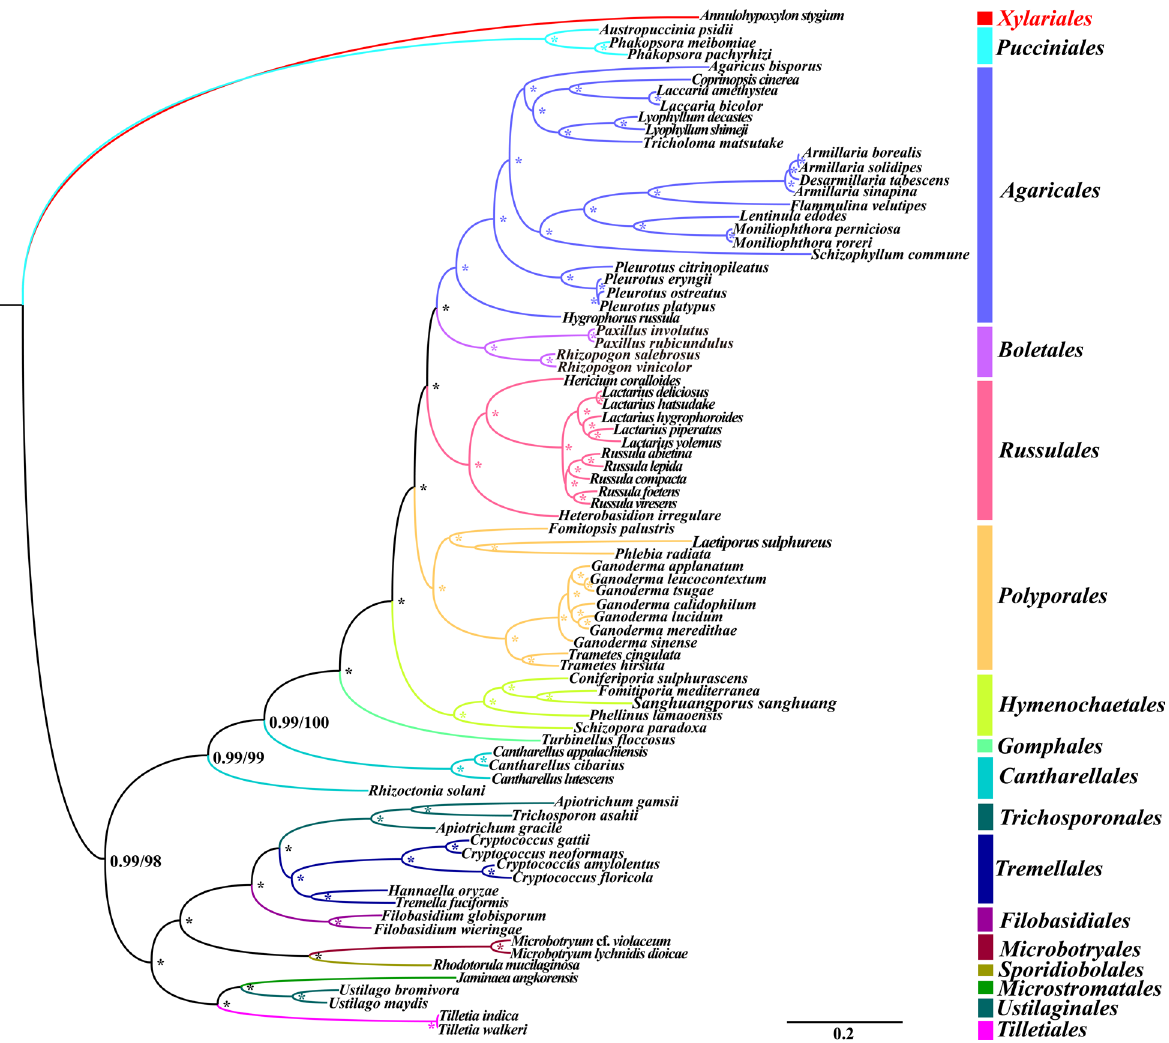
Fig. 8 Molecular phylogeny of 81 Basidiomycota species based on Bayesian inference (BI) and Maximum likelihood (ML) analysis of 15 protein coding genes. Support values are Bayesian posterior probabilities (BPP, before slash) and bootstrap values (BS, after slash). An asterisk indicates that the BPP and BS values are 1.00 and 100, respectively. Species and NCBI accession numbers for mitogenomes used in the phylogenetic analysis are provided in Additional file 1: Table